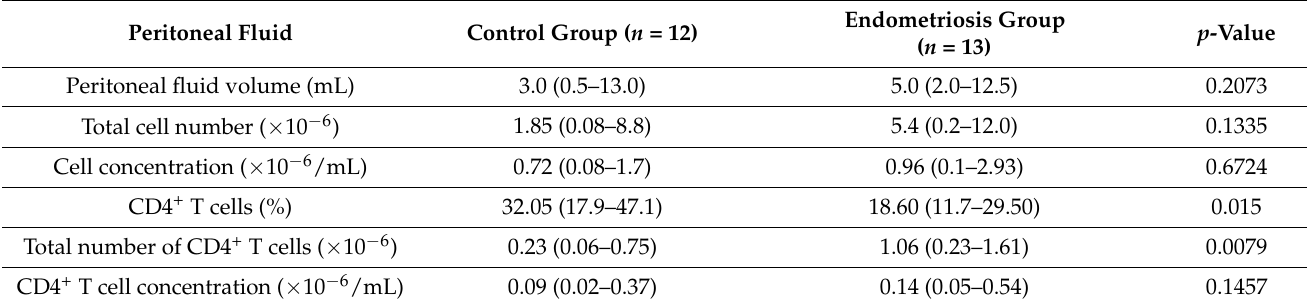
Table 1. Characteristics of the peritoneal fluid collected from control subjects and patients with endometriosis. Peritoneal Fluid